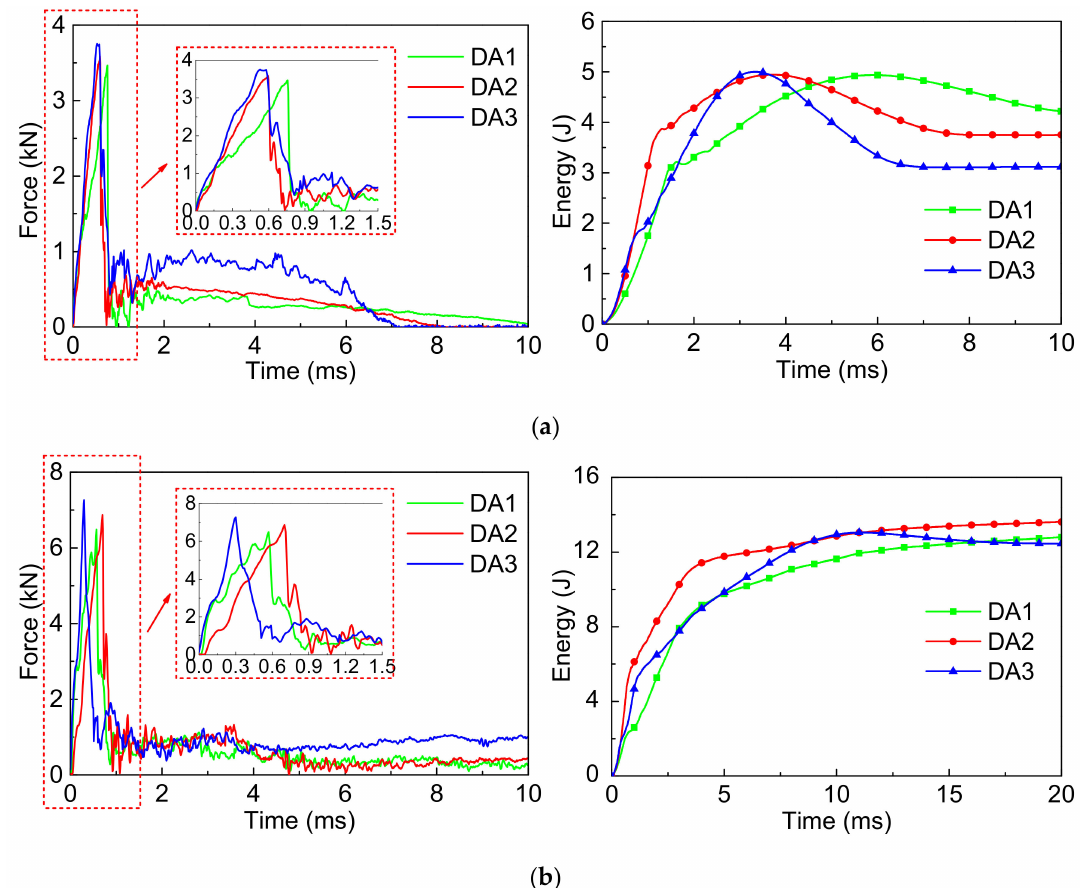
Figure 13. The force-time curves and energy-time curves of composites with different SMA diameters under the two impact energies: ( a ) Initial impact energy of 5 J; ( b ) Initial impact energy of 14